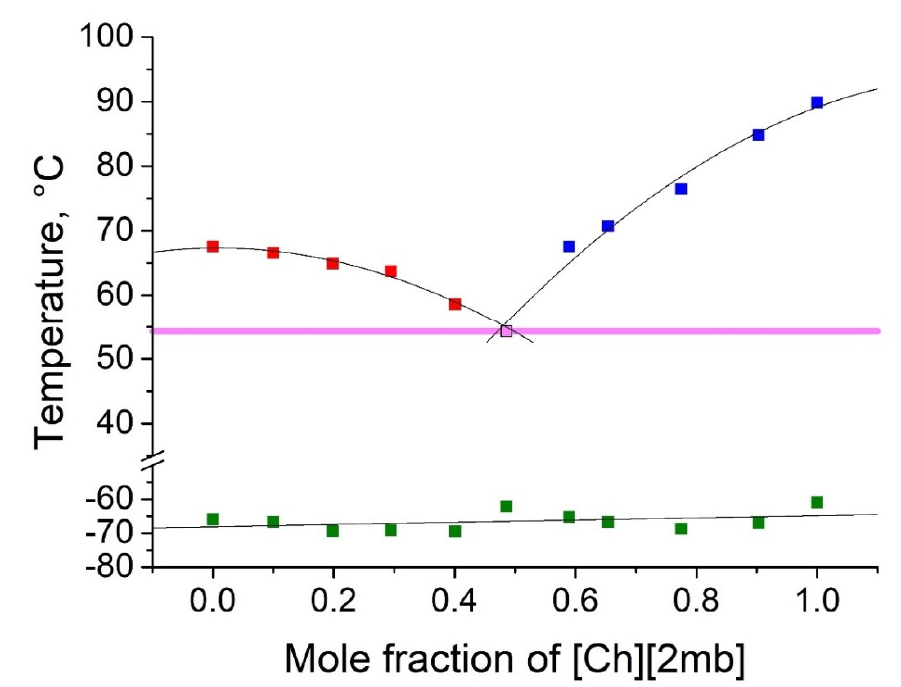
Figure 3. Temperature composition phase diagram for the mixture of [Ch][Ac] and choline isovalerate ([Ch][Iv]), and their individual components at 0.0 and 1.0 mole fractions. Legend: ▪—melting point of the excess component [Ch][Ac] in the mixture; ▪—melting point of the excess component [Ch][Iv] in the mixture; ▪—glass transition temperature; ▪—eutectic point; – eutectic transition line.